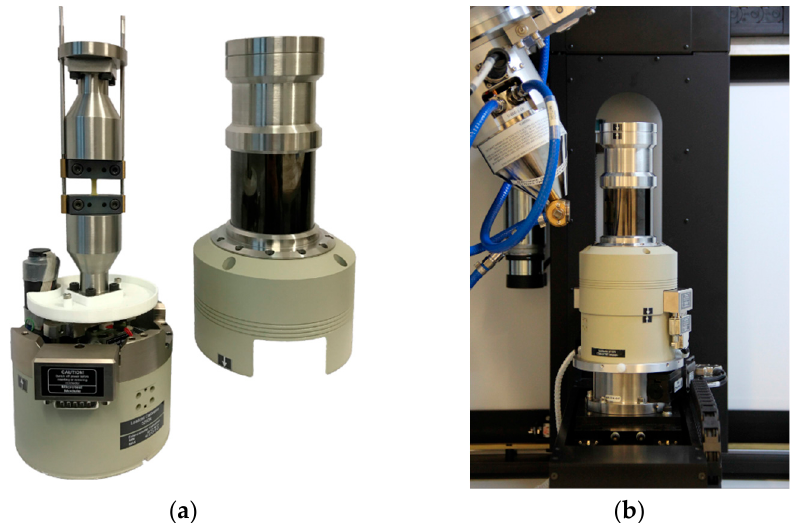
Figure 3. ( a ) In situ CT testing stage ( b ) implemented in CT chamber.